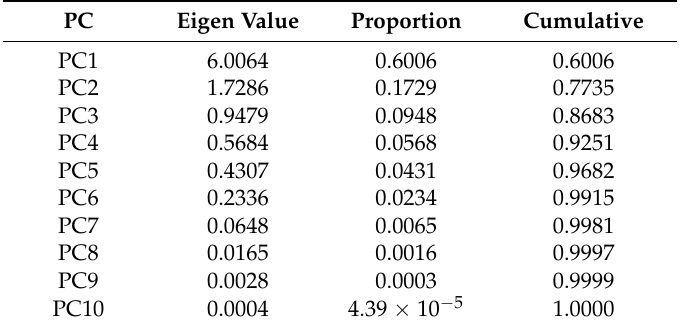
Table 2. Eigen analysis of the correlation matrix.